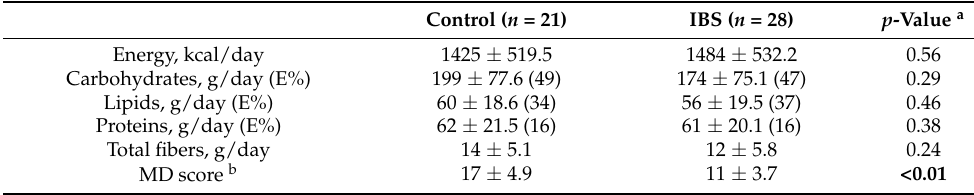
Table 2. Dietary Characteristics.